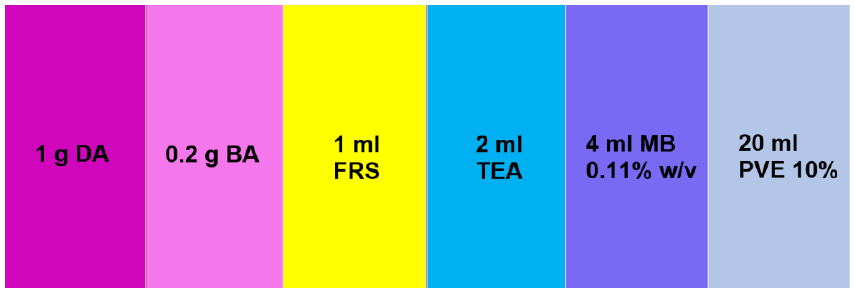
Figure 4. Chemical composition of the pressure-sensitive photopolymer layers.